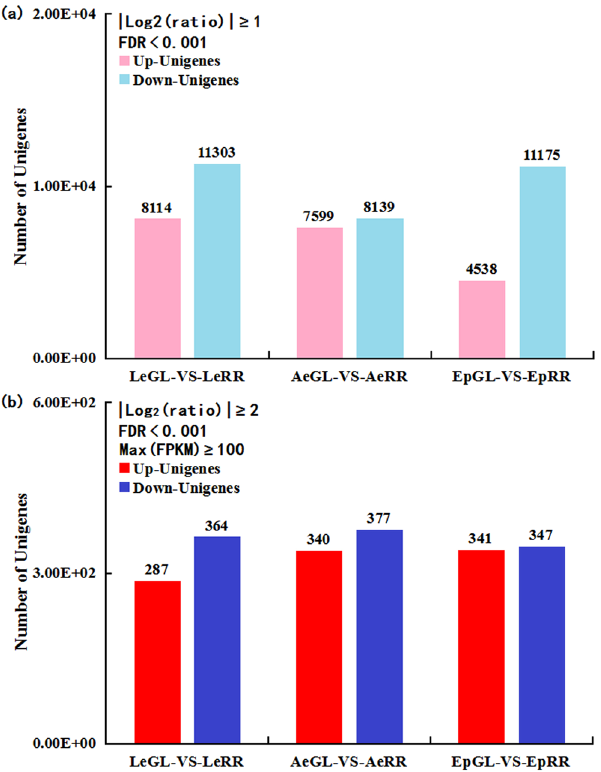
Figure 3. Unigene expression between GL and RR lines in Lithospermum erythrorhizon , Arnebia euchroma and Echium plantagineum . ( a ) Significantly differentially expressed unigenes (DEGs); ( b ) Highly significant differentially expressed unigenes